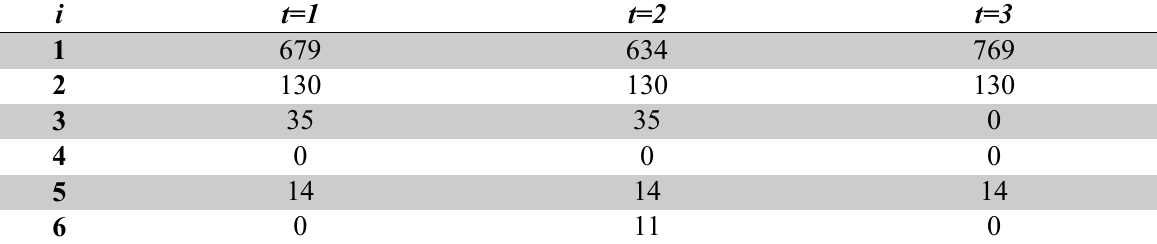
Inventory levels for each customer in each time period